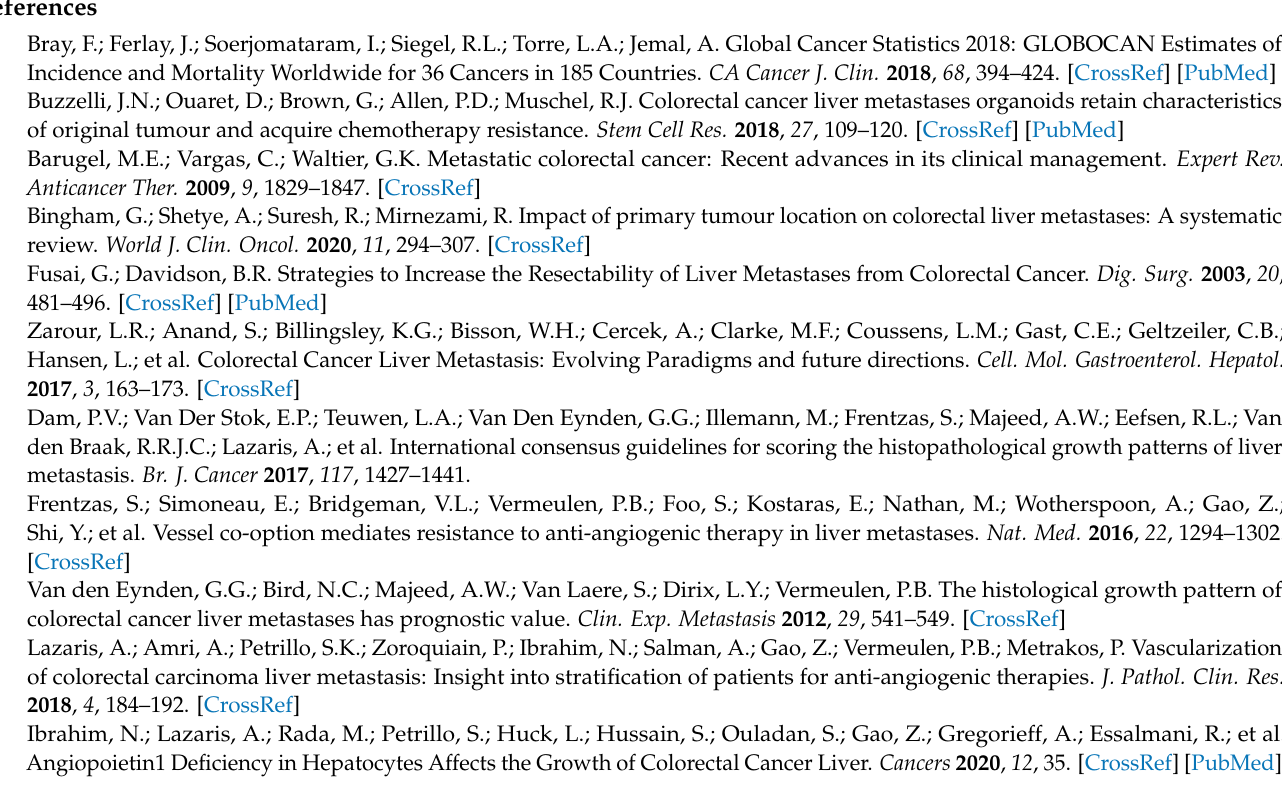
Figure S3: The role of RUNX1 in cancer cell-dependent hepatocyte apoptosis, Figure S4: TGF β 1 mediates cancer cell-driven hepatocytic alterations in vitro, Figure S5: Original uncropped western blots of Figure 2b, Figure S6: Original uncropped western blots of Figure 5a, Figure S7: Original uncropped western blots of Figure